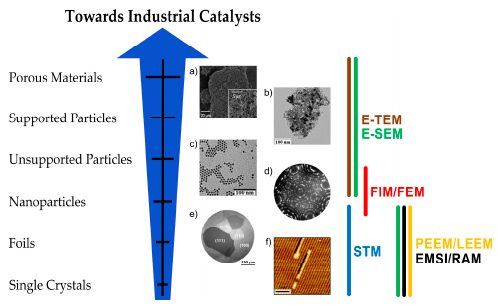
Figure 2. Schematic representation of catalysts samples of increasing complexity studied by different environmental microscopy techniques allowing the materials gap to be bridged. ( a ) Reproduced from [76]. Copyright 2015, MDPI; ( b ) and ( c ) Adapted with permission from [77]. Copyright 2016, American Chemical Society; ( d ) Reprinted from [78]. Copyright 2015, Springer; ( e ) Adapted